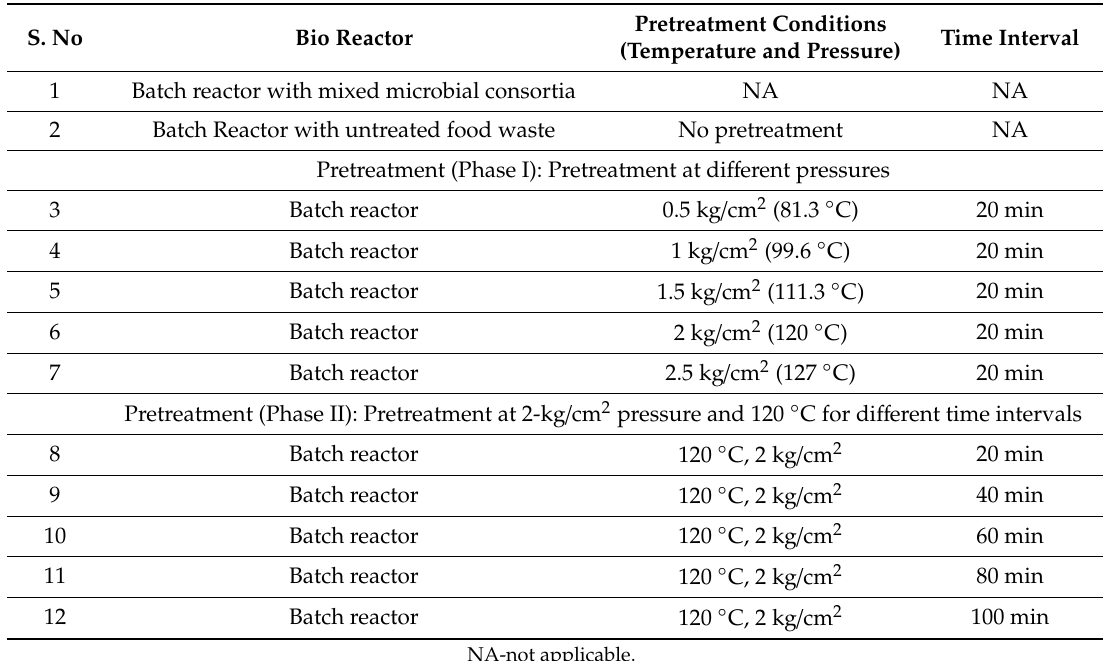
Table 1. Pretreatment conditions with bioreactor